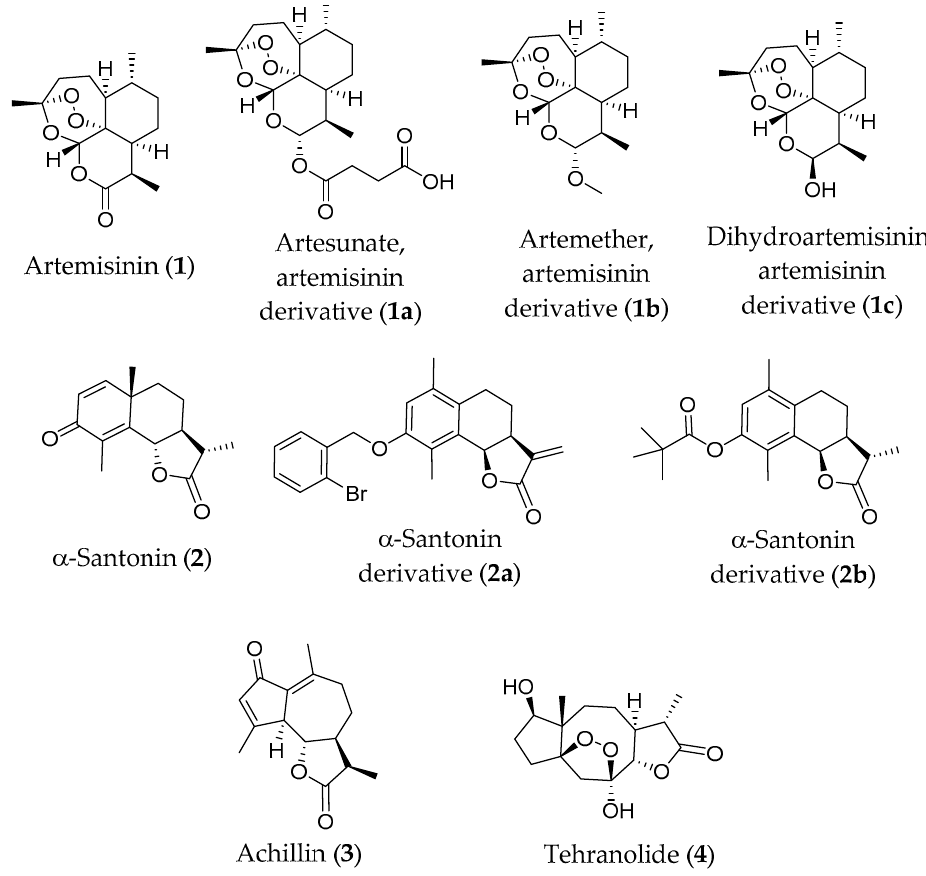
Figure 1. Chemical structures of some sesquiterpene lactones constituents of edible Artemisia sp. and derivatives with pharmacological